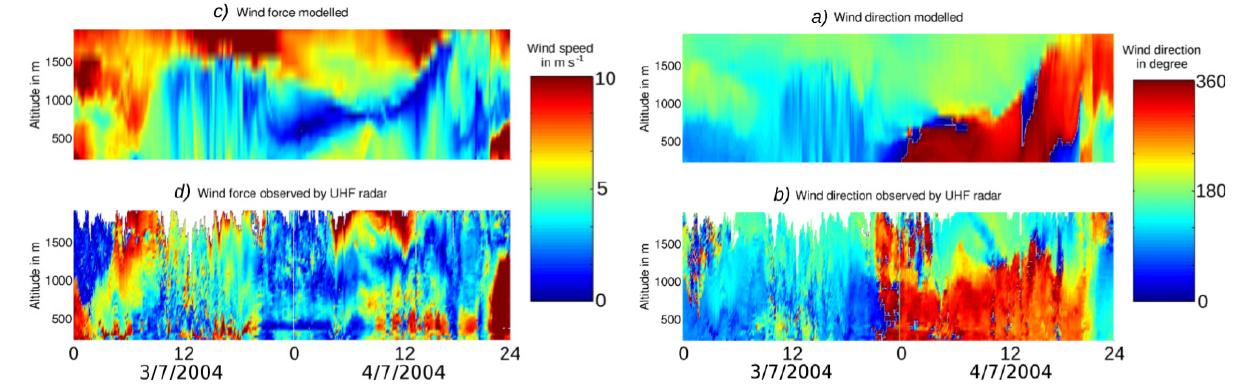
Fig. 4. Modeled and observed wind direction ( a and b , respectively) and wind speed ( c and d , respectively). Observations carried out by an UHF